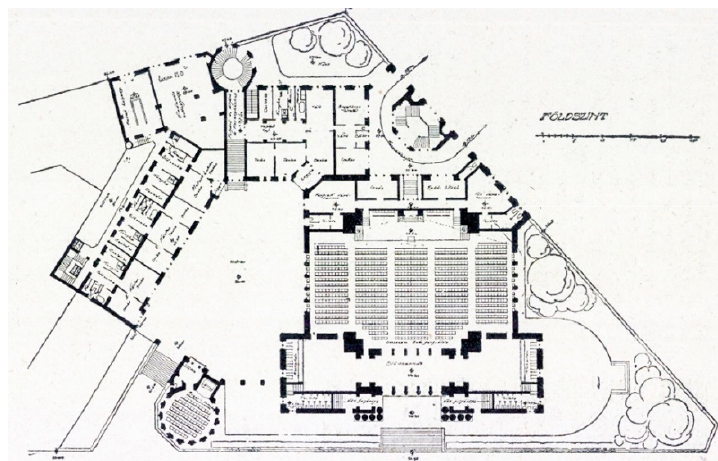
Figure 6. Floor plan, the attached buildings of the synagogue and the headquarters of the community